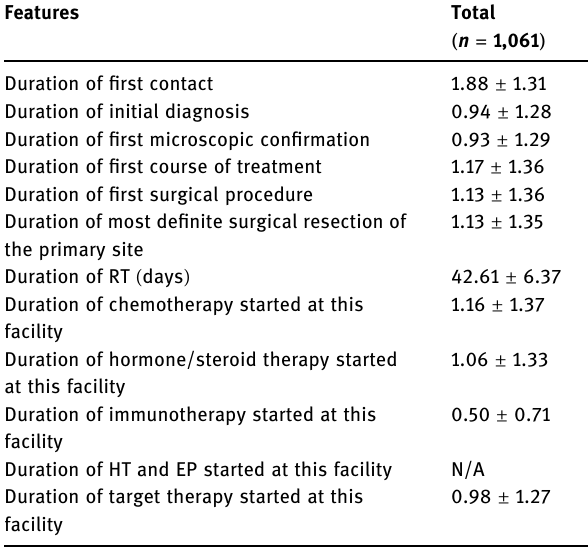
Table 1: The statistics of duration